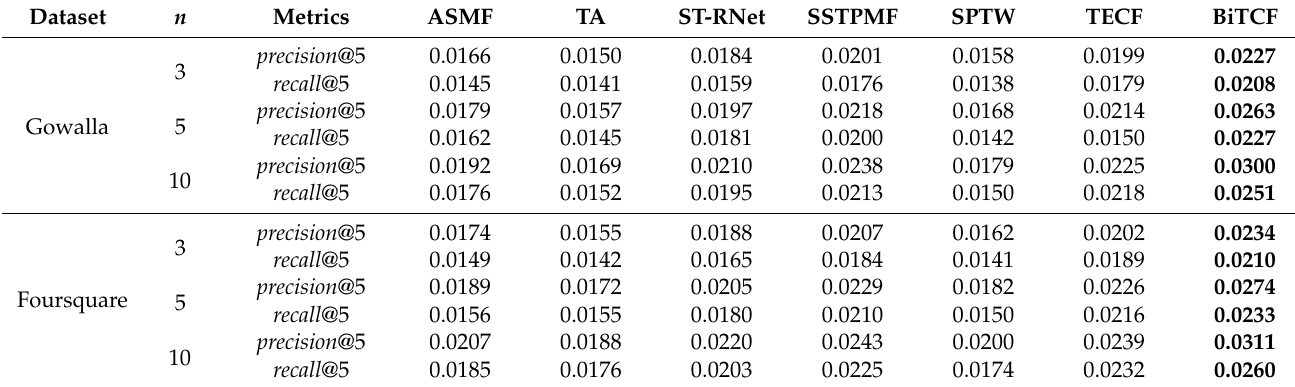
Table 5. Comparisons on the performance of the models in the cold-start